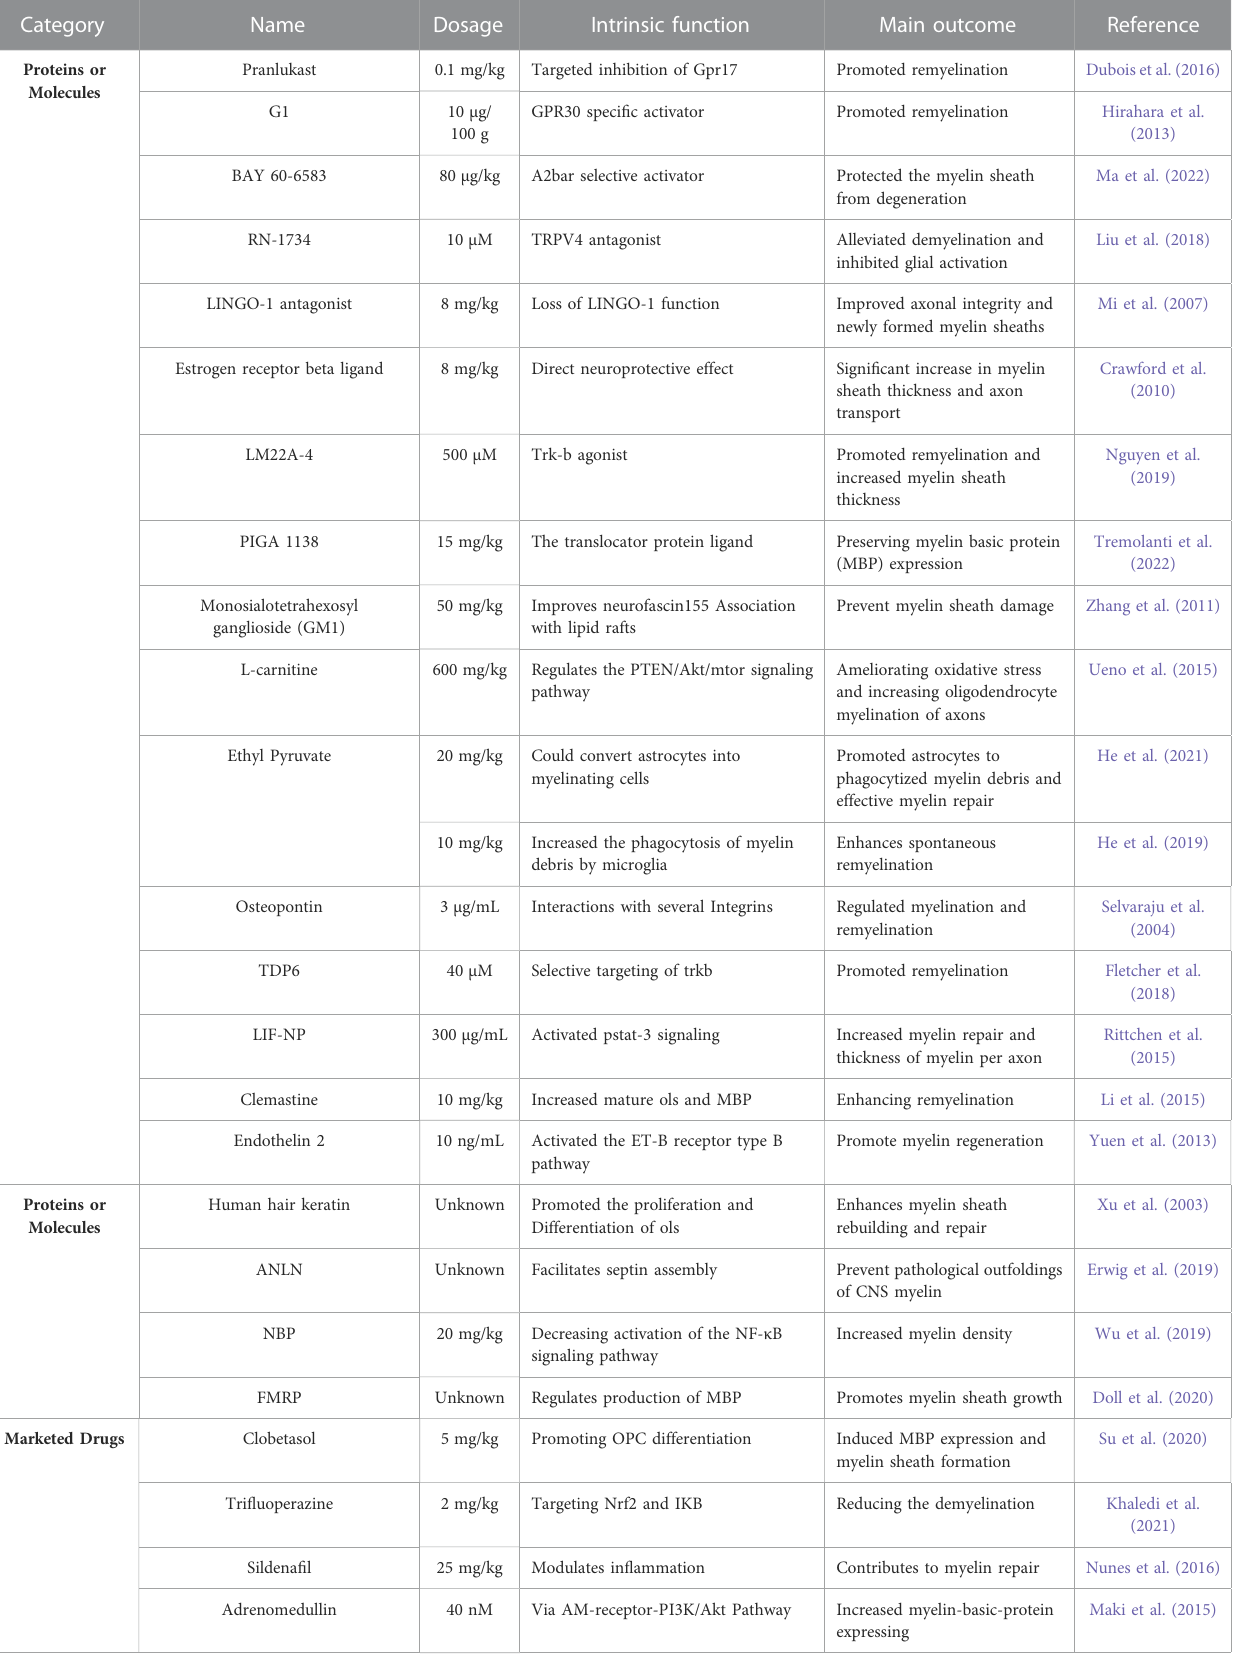
TABLE 2 Summary of therapeutic drug research on myelin sheath injury caused by other